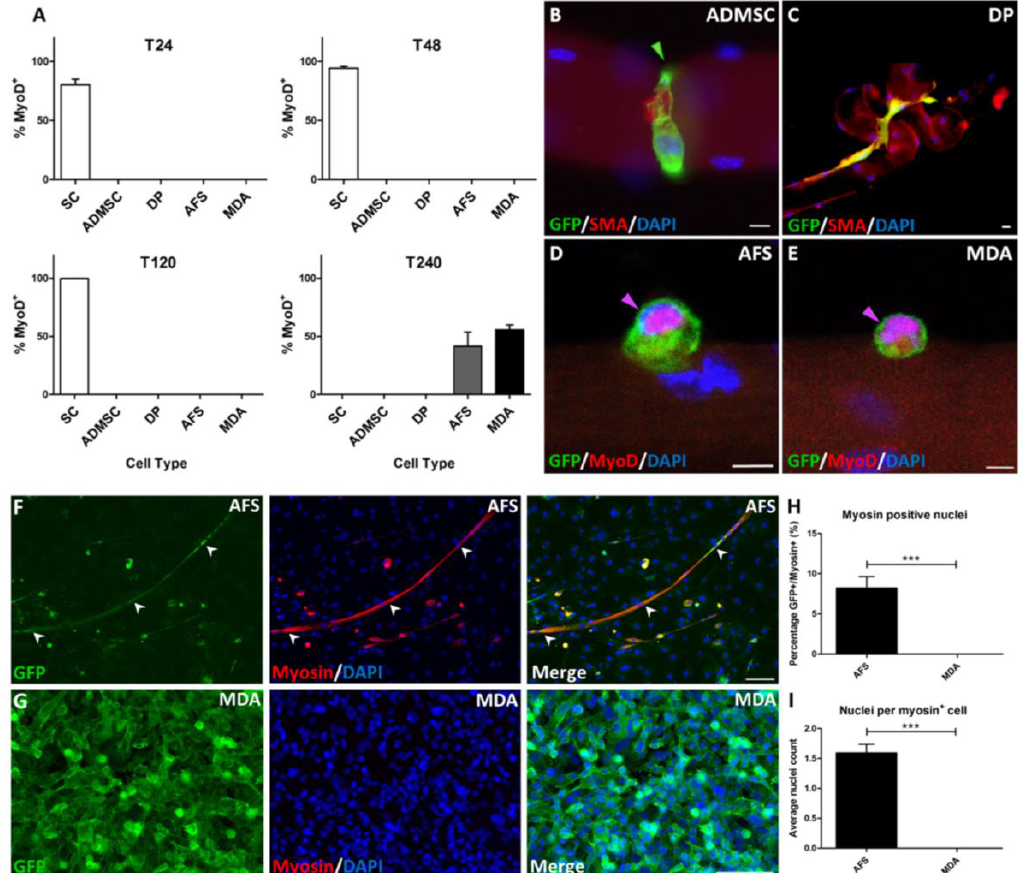
Figure 5. Induction of MyoD expression in AFS and MDA cells after prolonged culture on mouse myofibres. ( A ) Temporal profiling of non-resident cells on myofibres for MyoD expression; ( B ) ADMSC identified by GFP expression, constricting myofibre at T24; ( C ) DP cell distorting myofibre at T24; ( D ) AFS cell at T240 showing nuclear expression of MyoD co-localising with DAPI (indicated by magenta arrow); ( E ) MDA cell at T240 showing nuclear expression of MyoD co-localising with DAPI (indicated by magenta arrow); ( F ) AFS cells, identified by GFP expression, co-localising with myosin, fused to form elongated myotube structures (arrowheads); ( G ) MDA cells co-cultured with myofibres failed to initiate myosin expression; ( H ) Quantification of GFP + cells expressing myosin; ( I ) Number of nuclei per cell GFP + expressing myosin. Scale 10 µ m ( B – E ), and 100 µ m ( F , H ). In ( A – E ), n ≥ 12 myofibres